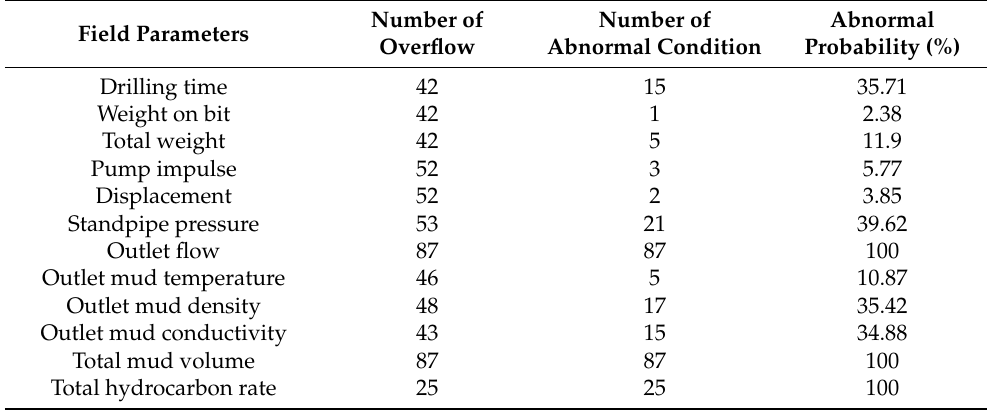
Table 1. Statistics of changes in various parameters during the overflow period. Field Parameters